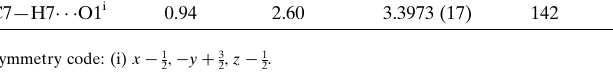
Table 2 Experimental details. Crystal data Chemical formula